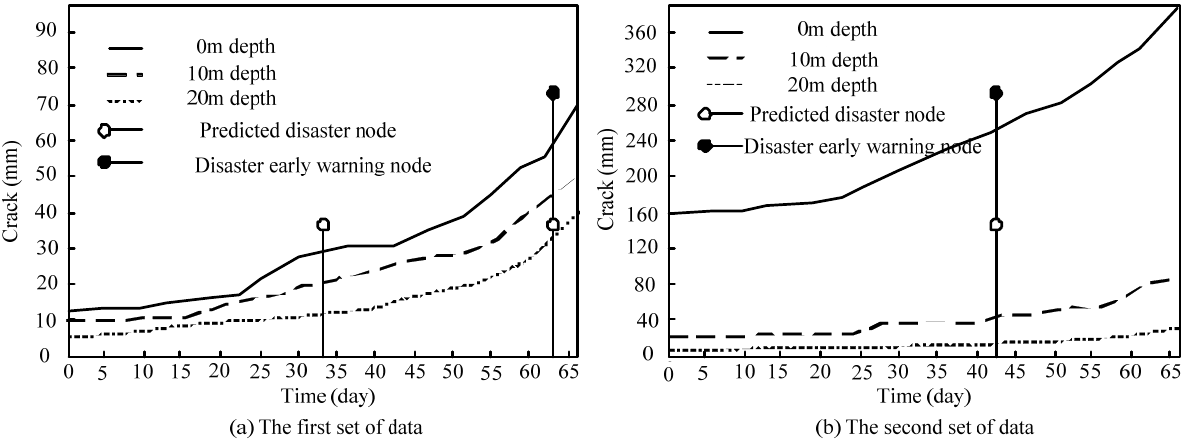
Figure 8. Early warning performance analysis of big data